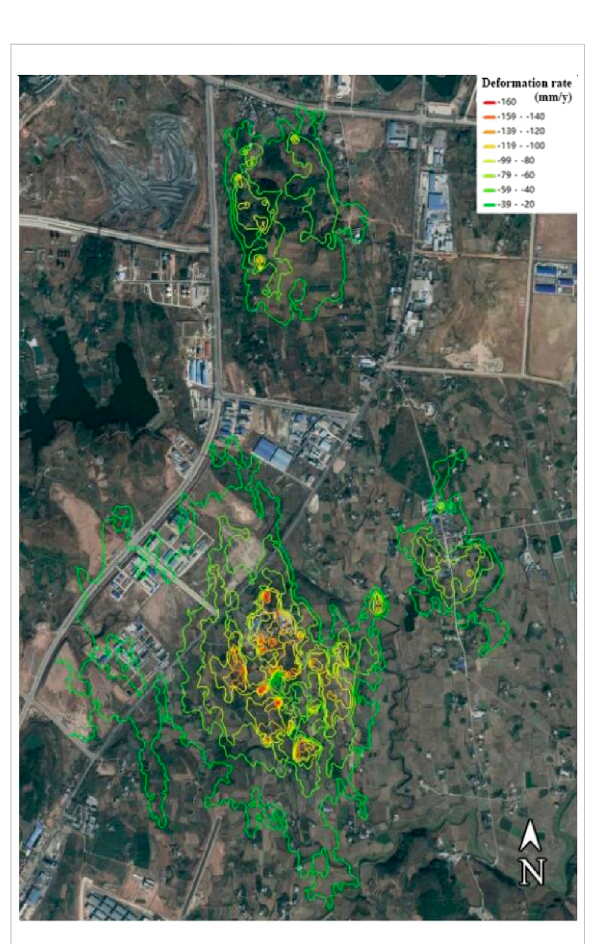
FIGURE 14 Diagram of the in fl uence range of the deformation